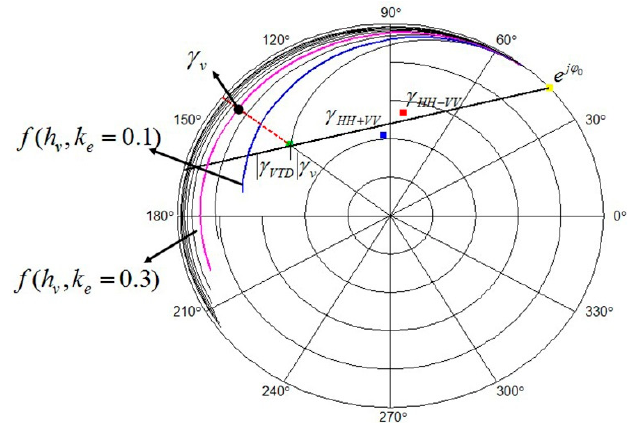
Figure 14. The geometrical representation for the coherence locus selection using three-stage and four-stage algorithms. The blue and magenta curves are the fixed coherence loci selected using RVoG and RVoG+VTD models, respectively. The dotted red line is the ambiguous line segment for γ v